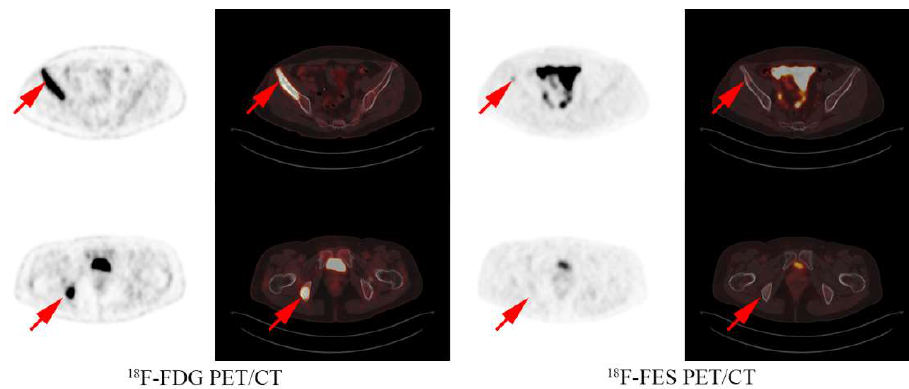
Figure 4. Analysis examples: A 53 year old female had both FES positive and negative lesions in the bone and received capecitabine treatment with a PFS of 15 months.